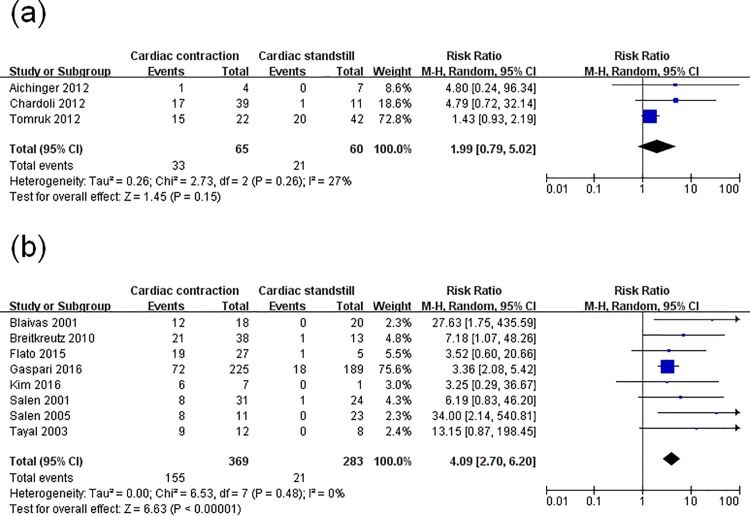
Forest plot of the subgroup analysis of cardiac activity on the restoration of spontaneous circulation.(a) studies whose ultrasound evaluation focused only on the subxiphoid; (b) studies whose ultrasound evaluation used various views.